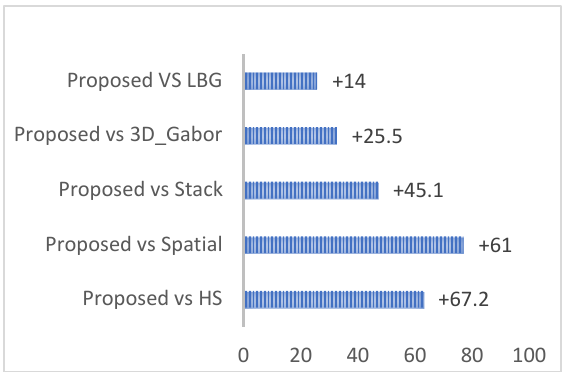
Figure 7. The McNemar test for proposed and other